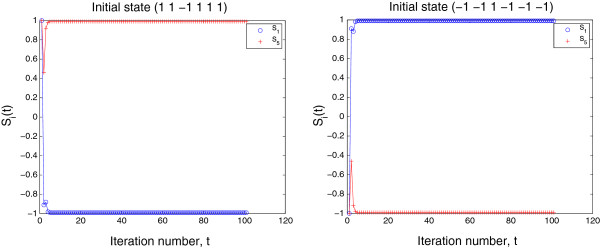
Projections of two trajectories with initial states S1(0) and S2(0)(=−S1(0)), respectively, in Example 3 onto two-dimensional (S1,S5)-subspace.